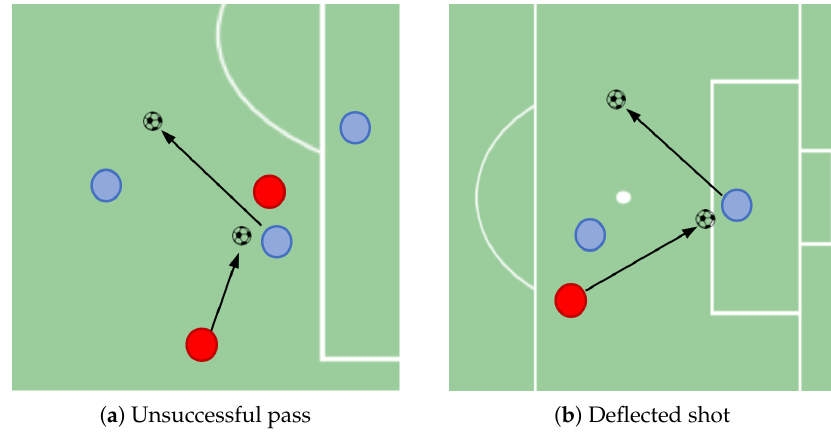
Figure 2. A scheme of an unsuccessful pass and a deflected